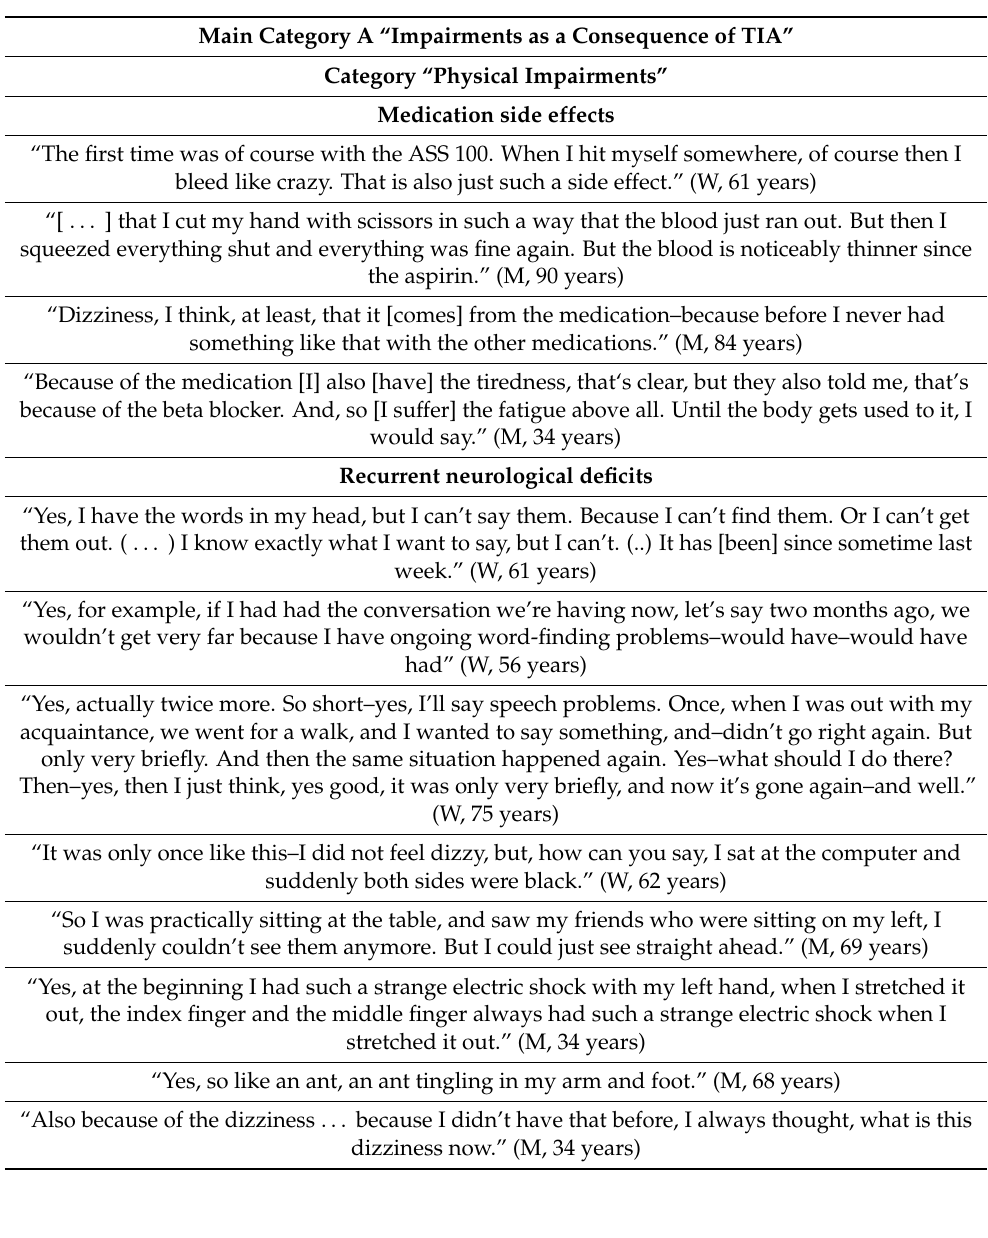
Table A1. Example quotes on the themes and categories within the main category A “Impairments as a Consequence of